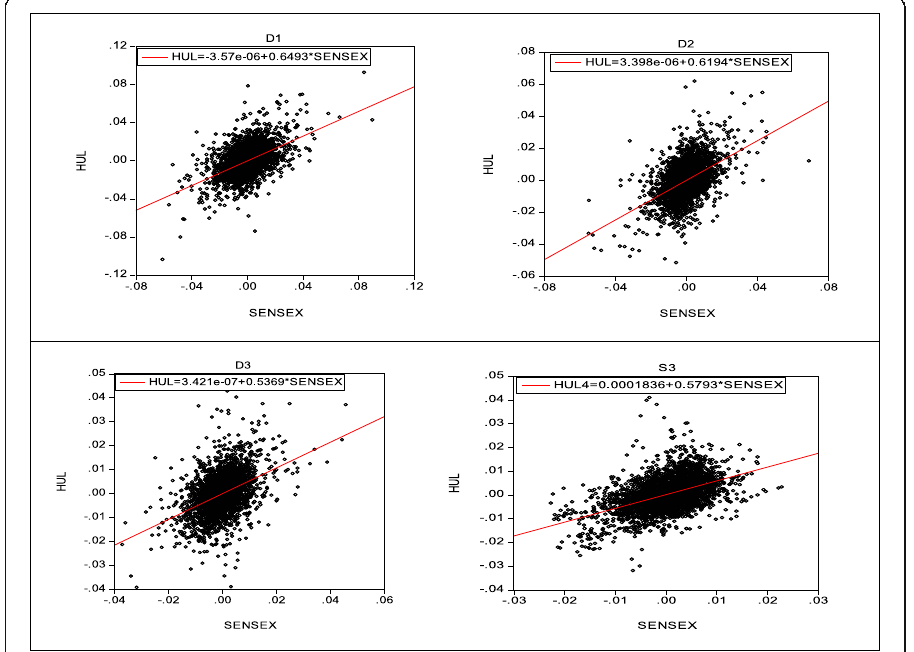
Fig. 4 Wavelet decomposition of return series. Hindustan Unilever Limited stock return (vertical axis) versus Sensex return, measured at different time scales based on wavelet decomposition. The wavelet scales are such that scale one (D1) corresponds to the time period of 1-2 days, scale two (D2) - 2 to 4 days, Scale three (D3)- 4 to 8 and S3 represents the undefined but longer time period. It can be noticed that when the return interval is increased in a given sample period, the number of sample points remains the same and hence no loss of